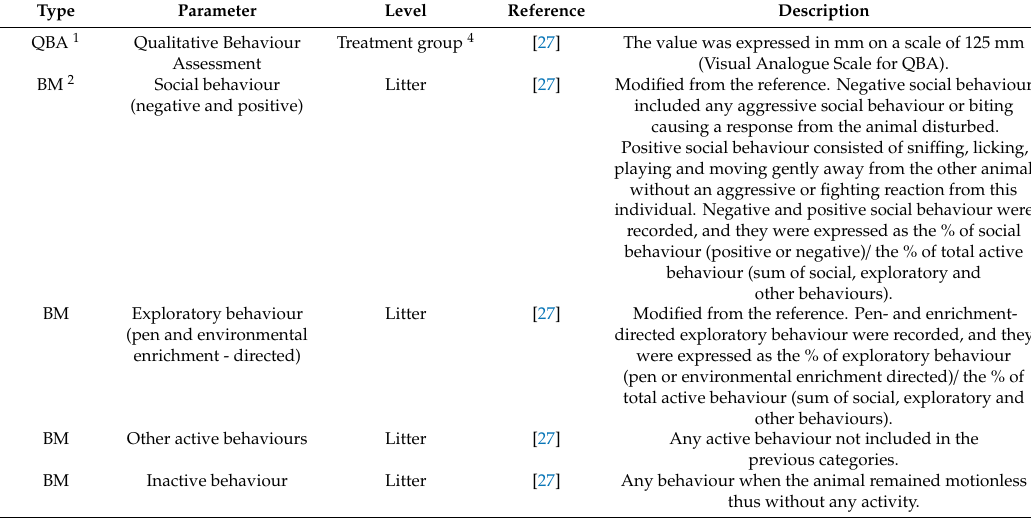
Table 1. List of parameters measured in the study, level of sampling, references and description. The parameters were ordered according to the time-line of the